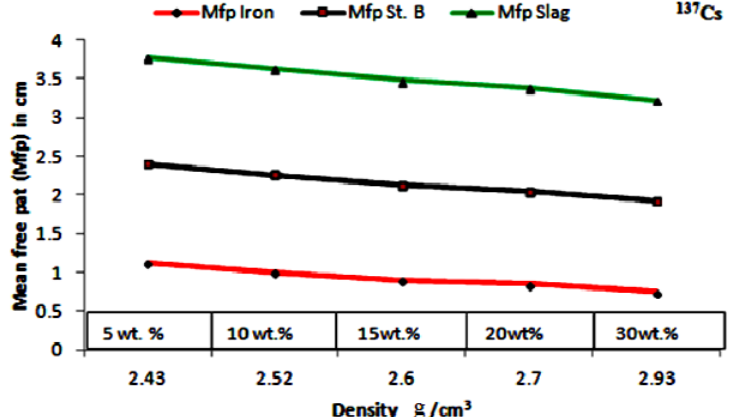
Figure10. The measured mfps for concrete samples at different loading rates of iron fillings, steel balls and slags for the 137 Cs source against the bulk density of the